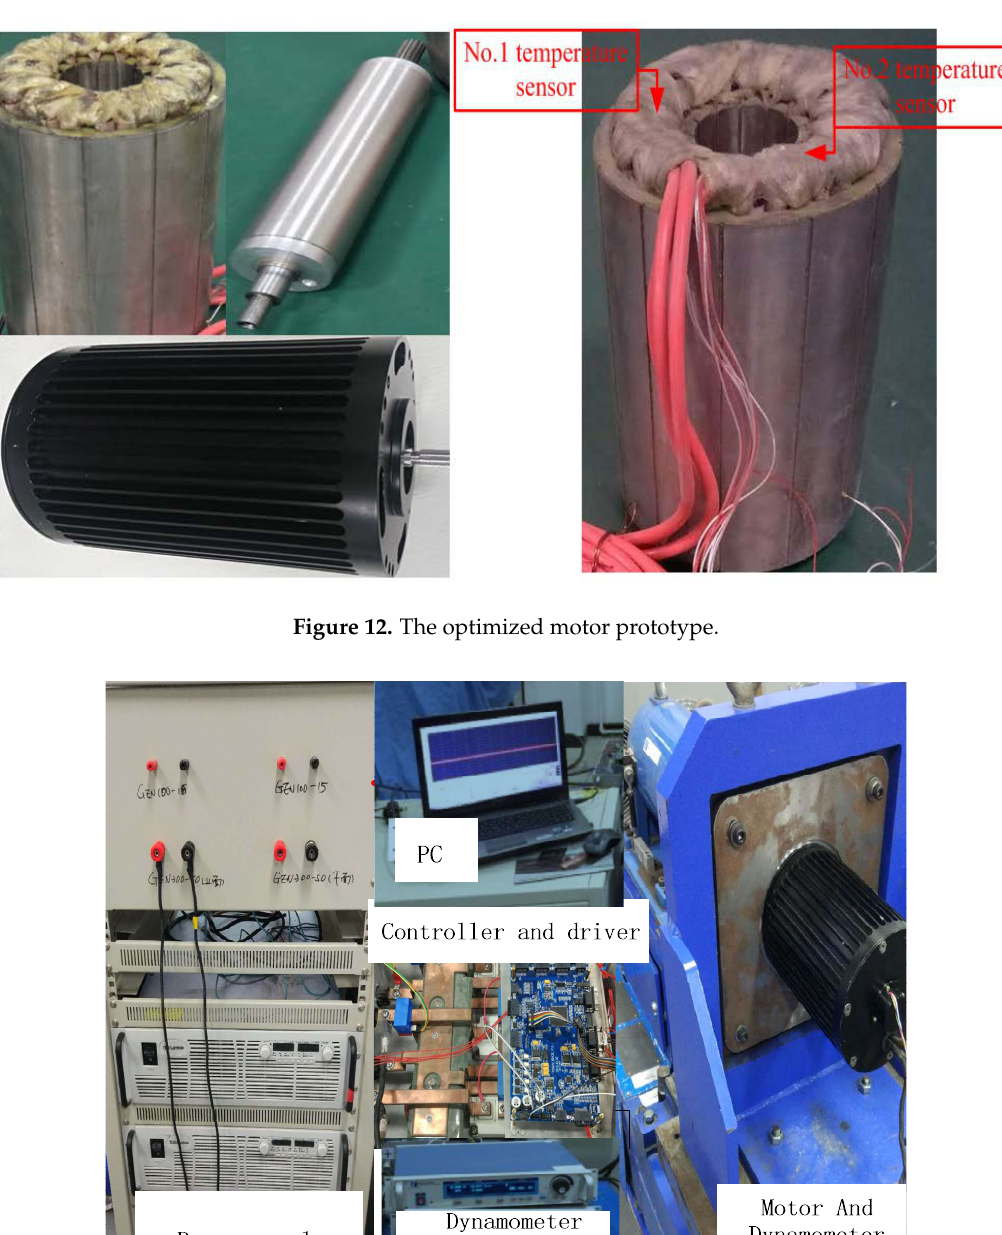
Figure 14. Temperature comparison. As the difference between the two test points was very small, than the temperature of test point 1 is shown in Figure 14. It can be seen that there was a discrepancy between the test results and the transient thermal analysis by FEA. The temperature of test point 1 was larger than the results of transient thermal analysis. In the transient thermal analysis, there were assumptions and many factors that were not considered in the calculation such as the airgap between the housing and the stator core, stator core and winding. The model of transient thermal analysis was not full consistent with the actual motor. Therefore, there were errors between the theoretical analyses and the experimental results. Furthermore, the focus of this paper was on the optimal design method of heat dissipation for low temperature rise and low weight. Therefore, the small error between the theoretical analyses and experimental had little influence on the optimal design. 01020 3040